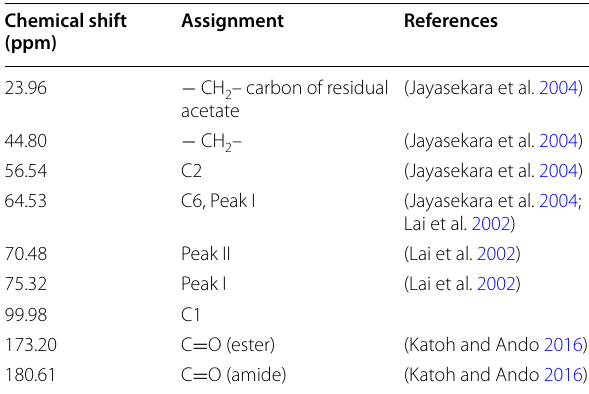
Table 2 Chemical shifts of C in the pure and blended hydrogels Chemical shift (ppm)